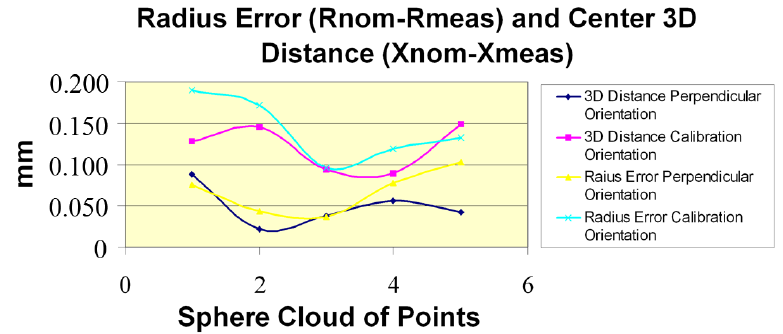
Figure 13. Accuracy estimation of the whole system. Radius and centre distance errors digitizing a reference